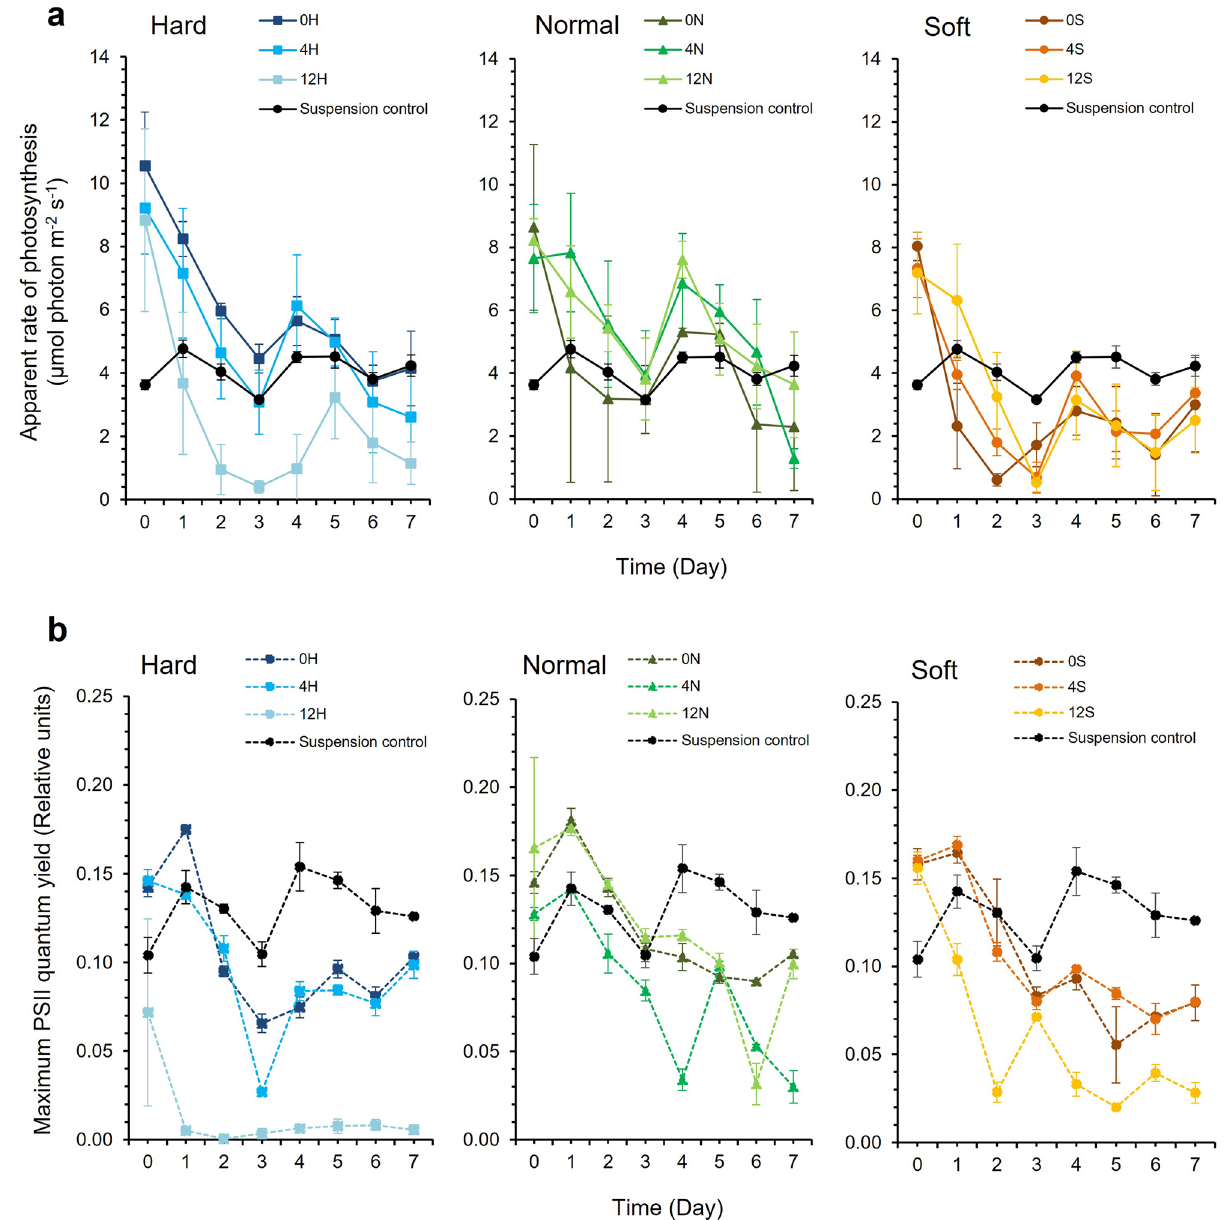
Figure 2. ( a ) Apparent rate of photosynthesis (PS) and ( b ) Maximum PSII quantum yield (F v /F m ) of Synechococcus elongatus PCC 7942 in response to latex formulation compared to suspension culture controls. ‘Hard’ (H) latex had a styrene to butyl acrylate ratio of 1:3, ‘normal’ (N) was 1:1, and ‘soft’ (S) was 3:1. The preceding number in the latex code corresponds to the Texanol content. (Mean ± StDev; n =